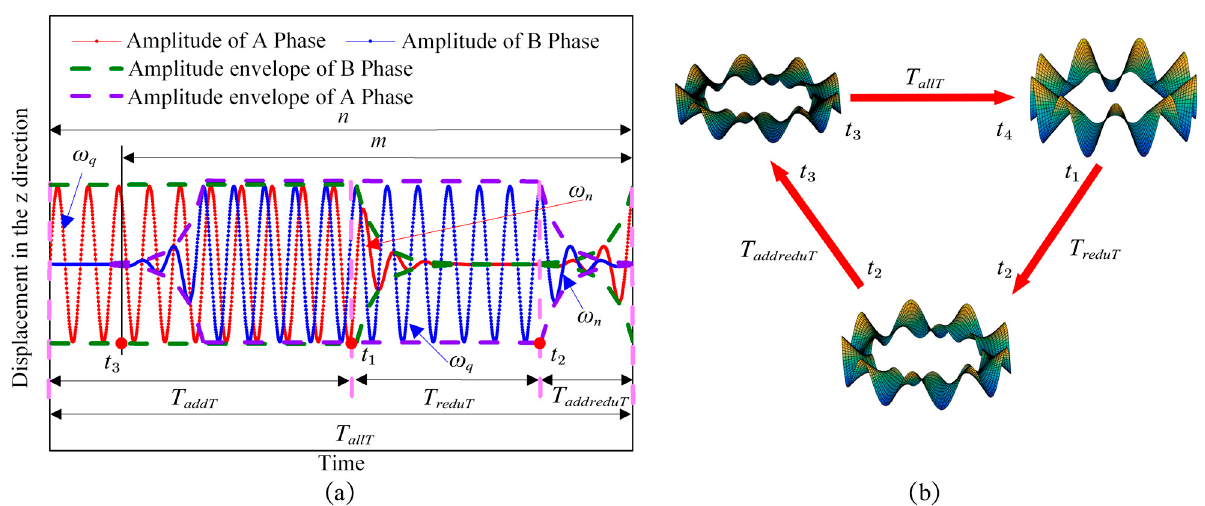
Figure 3. A schematic diagram of the two-phase excitation response based on the superimposed pulse driving method: ( a ) a schematic diagram of the two-phase excitation response; and ( b ) a simulation diagram of the stator modal